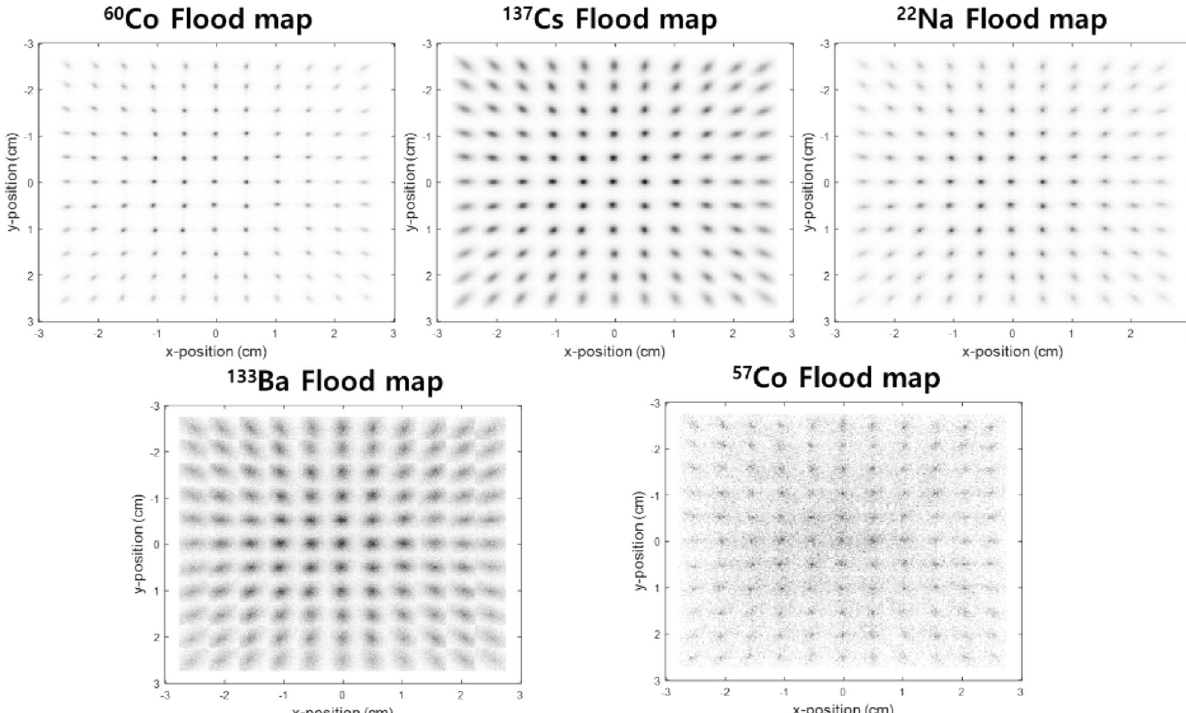
Figure 1. Measured 2D flood map of 12 × 12 pixels in stilbene-SiPM array module for 60 Co, 137 Cs, 22 Na, 133 Ba, and 57 Co gamma irradiation. The source activity of each gamma-ray source was 0.312 MBq and the 10 cm distant source was measured for 1 h. The 12 × 12 stilbene scintillator had pixel dimensions 4 × 4 × 20 mm 3 for by pixel-by-pixel gain calibrations for every element coupled to the SiPM 12 . An energy calibration to units of keVee was subsequently made using the linear light output response functions to photon interaction. The pulse shape discrimination metric plot is shown in Fig. 4, which was acquired by measuring a 3.5 × 10 5 n/s 252 Cf spontaneous fission source 50 cm distant from the detector module. The description and evaluation of the PSD metric is detailed in the Methods section. Gamma-ray events are dominant below the dashed line shown in the figure while the neutron events are predominant above the dashed line. At the energy of 200 keVee, the overall detector PSD plot has a partial overlap between the gamma-ray and neutron distributions that makes it difficult to isolate the relevant particle species; however, once PSD sorting is applied for each pixel, as shown in Fig. 5, a clearer distinction between the neutron and gamma-ray events above the energy of 100 keVee is observed. The measurements thus indicate that gamma/neutron discrimination is achievable on a pixel-by-pixel basis. In addition to the PSD plot in Fig. 6a, a figure of merit ( FOM ) that measures the effectiveness of the gamma/ neutron discrimination is defined in the Methods section and shown graphically in Fig. 6b. The FOM profiles that visualize the neutron/gamma-ray separation at different energy regions: 300 ± 100 keVee, 500 ± 100 keVee, 700 ± 100 keVee, are presented, when the stilbene detector is exposed to combined 252 Cf and 137 Cs sources. The was located 30 cm away from the detector module. The high intensity of counts in the 300 to 500 keVee region of the gamma-ray section of the PSD plot correspond to the Compton edge and the Compton continuum regions of tion to units of keVee. Figure 6c shows the PSD plot that one of the pixels has, and the corresponding FOM values higher than 1.55 were achieved for the aforementioned three cases, as shown in Fig. 6d. It should be noted that a